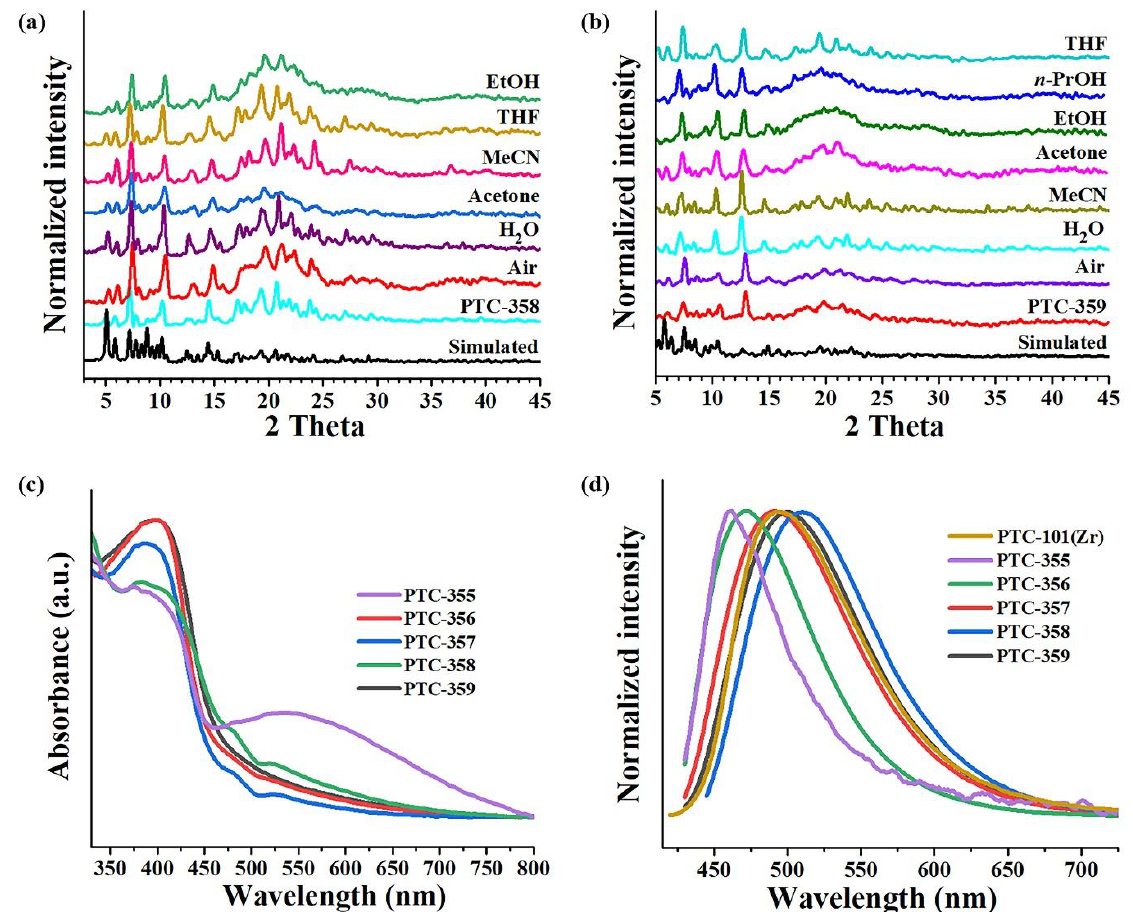
Figure 3. ( a , b ) The stability study for PTC-358 and PTC-359 (Some crystals were exposed to air for 12 h or immersed in different solvents for 1 day). ( c ) Solid-state UV/vis absorption spectra of PTC-355 – PTC-359 . ( d ) Normalized emission spectra measured in air at room temperature for PTC-101(Zr), compounds PTC-355 – PTC-359 .